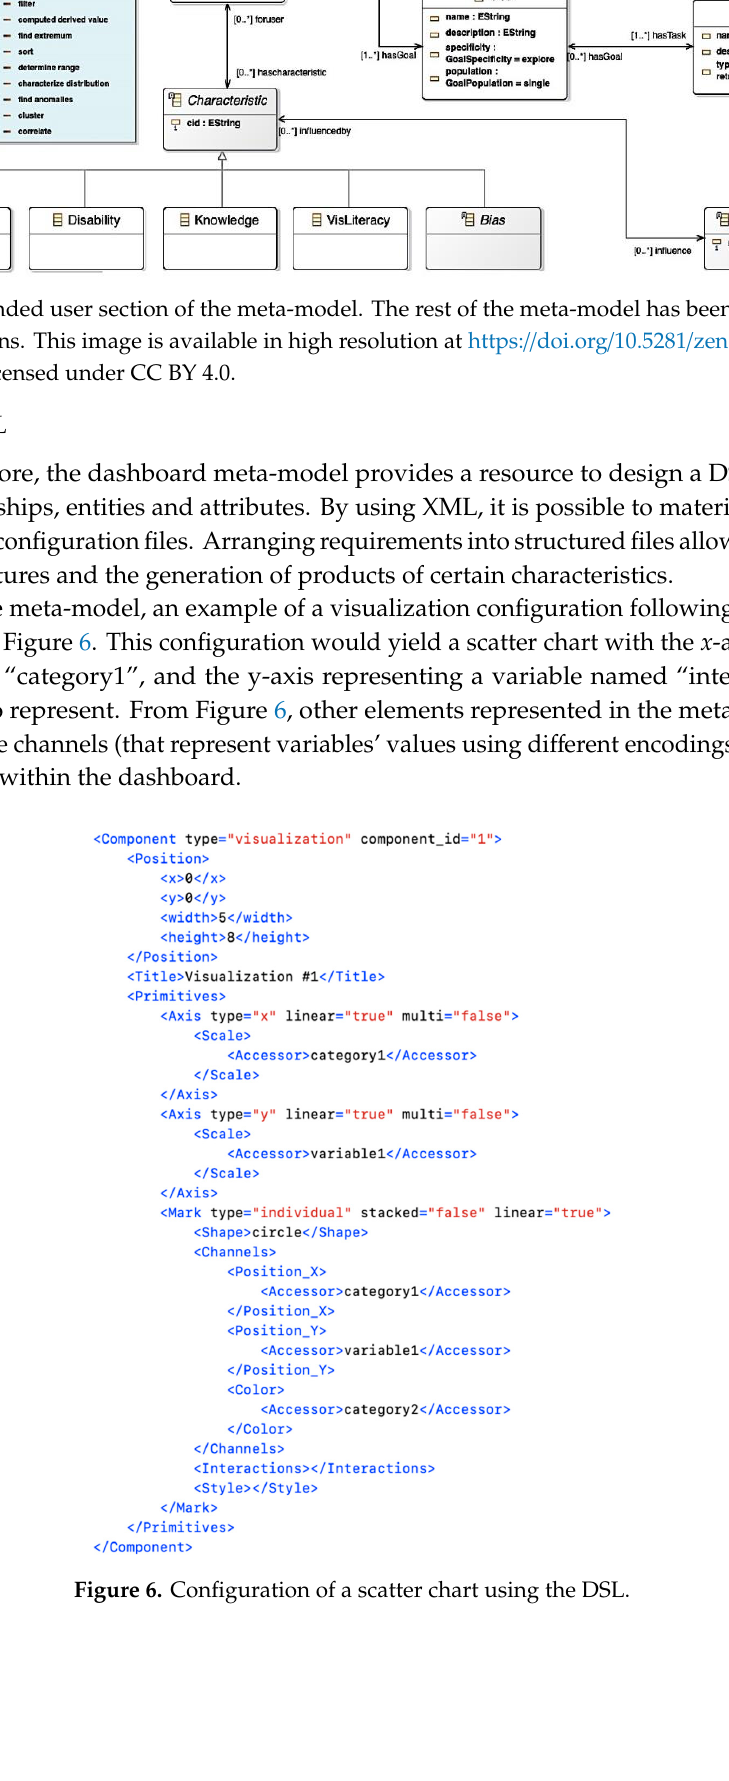
Figure 6. Configuration of a scatter chart using the DSL.